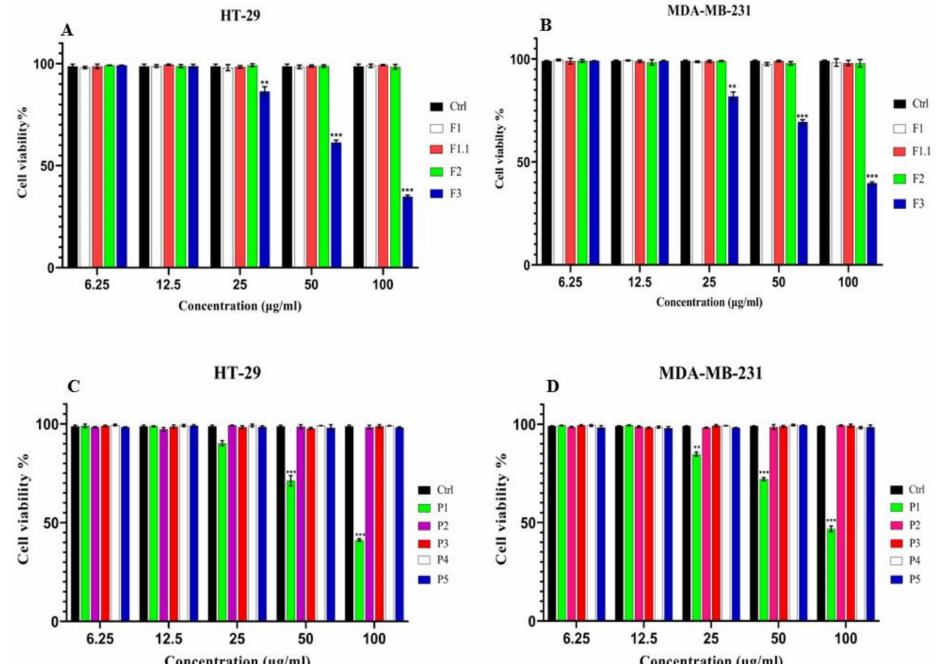
Figure 2. Cell viability of HT-29 and MDA-MB-231 cell lines. Fraction F3 obtained by gel-filtration chromatography showed the maximum anticancer activity ( A , B ). Amongst RP-HPLC- derived fractions, Fraction P1 showed the highest cytotoxicity against both cell lines ( C , D ); N = 3, p < 0.01 (**) and p < 0.001 (***).